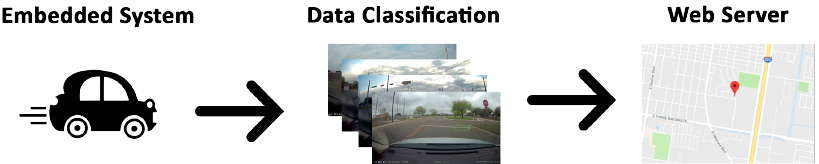
Figure 1. Overview of the proposed system; the embedded system mounted on a volunteers car will capture images while driving normally; then, the system will process the images in real time and send data to a remote server only if the image contains at least one of our proposed classes; the server will then save the image and location of said